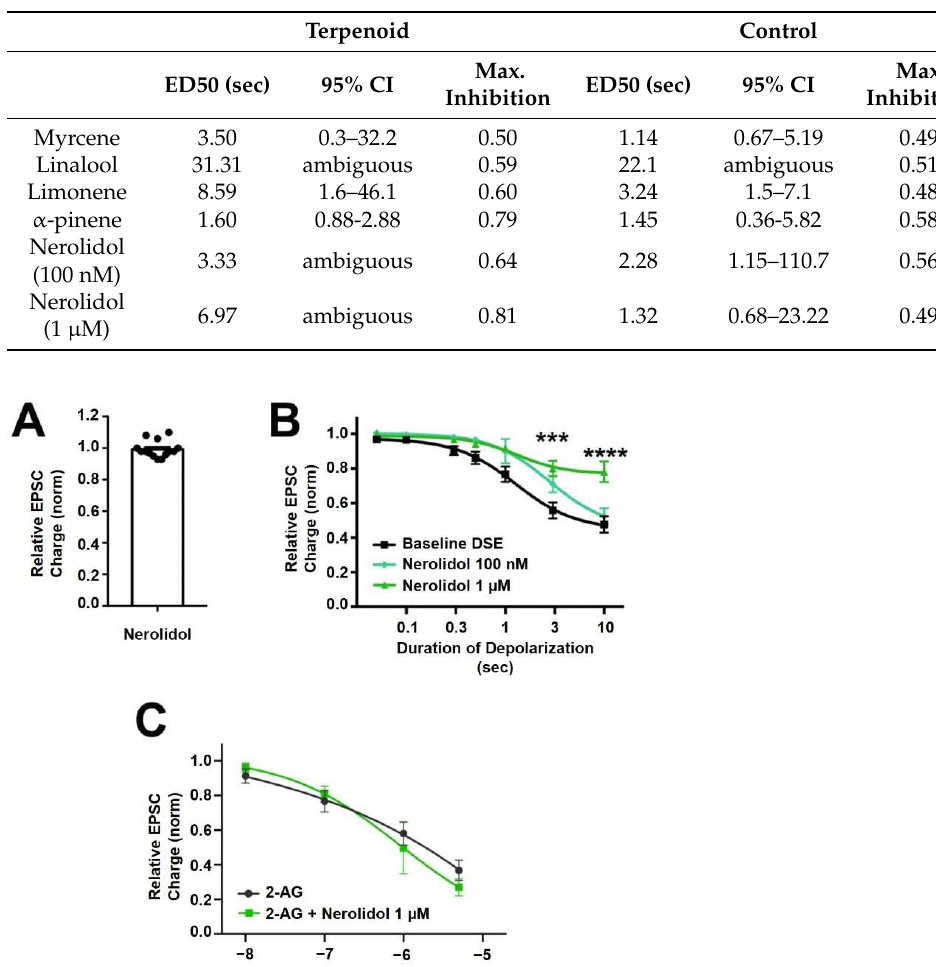
Table 1. Effective dose 50 (ED50, with 95% confidence interval) calculated from depolarization- response curves indicates the duration of depolarization (in sec) necessary to produce 50% maximal response. Maximal inhibition shows relative EPSC values at the longest depolarization (10 s, 1.0 = no inhibition).